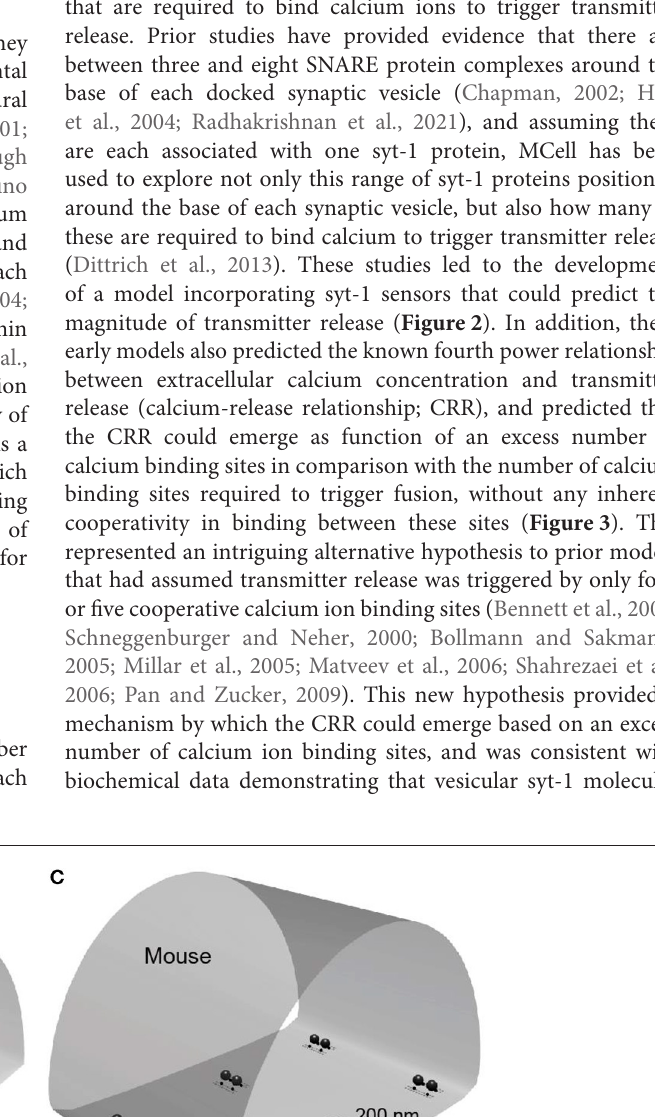
Frontiers in Synaptic Neuroscience |